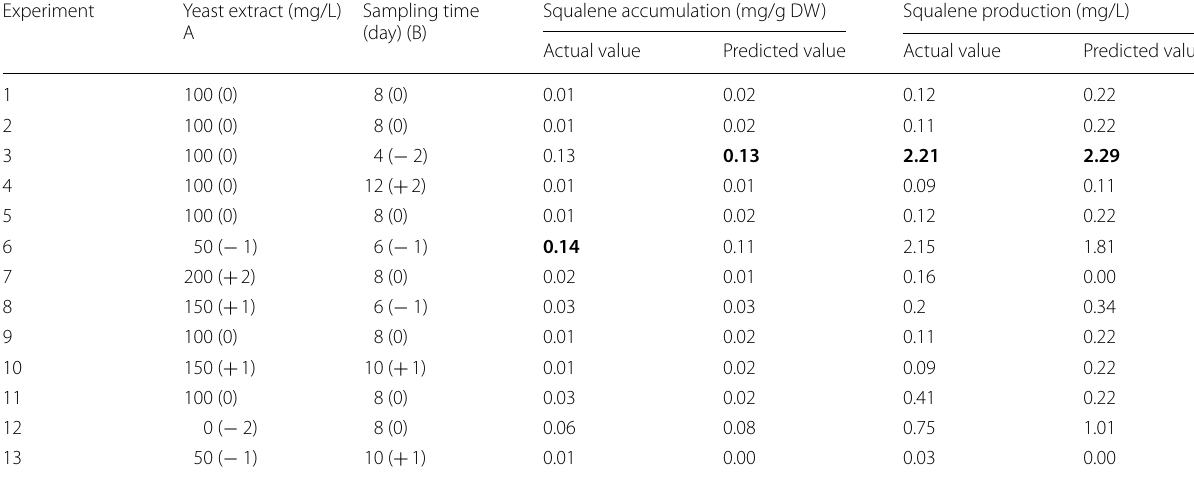
Bold values indicated the highest amount